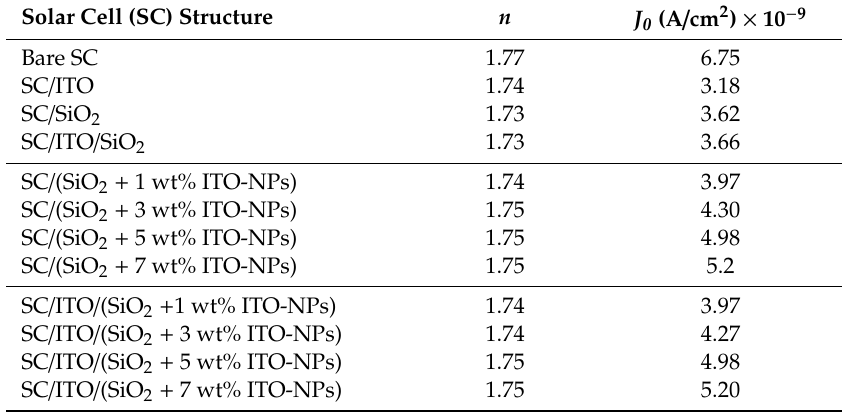
Figure 6. Dark I-V curves of the bare silicon solar cell, a solar cell coated with a SiO 2 layer (no ITO-NPs), a solar cell with an ITO layer, and solar cells coated with a layer of SiO 2 containing various concentrations of ITO-NPs. Table 1. Ideality factor ( n ) and reverse saturation current ( J 0 ) of all fabricated cells.